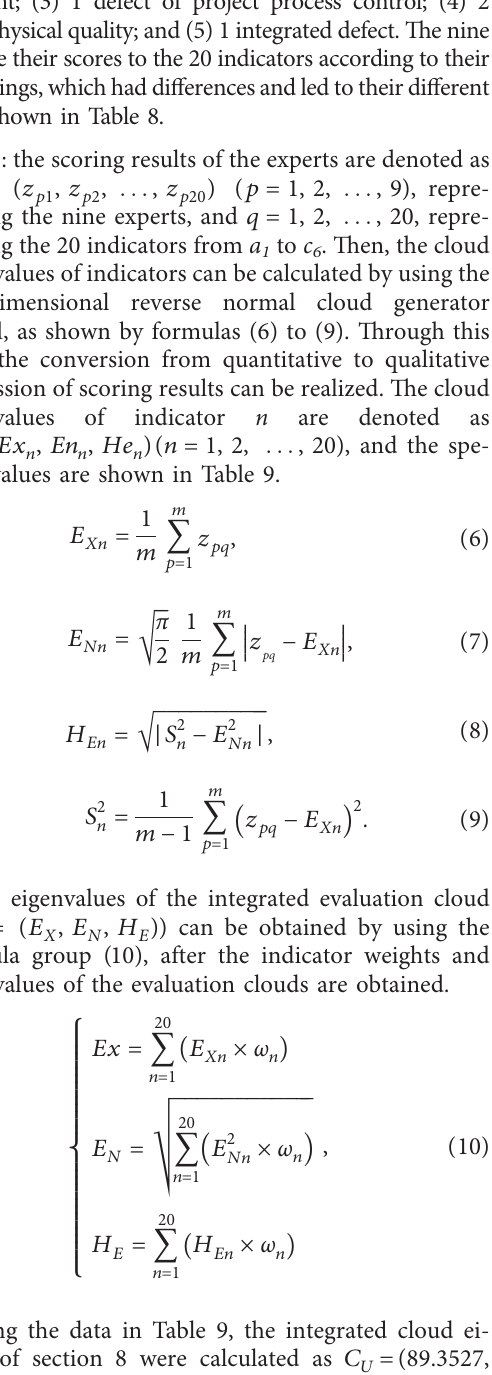
’ is just as important as u k ’ 1